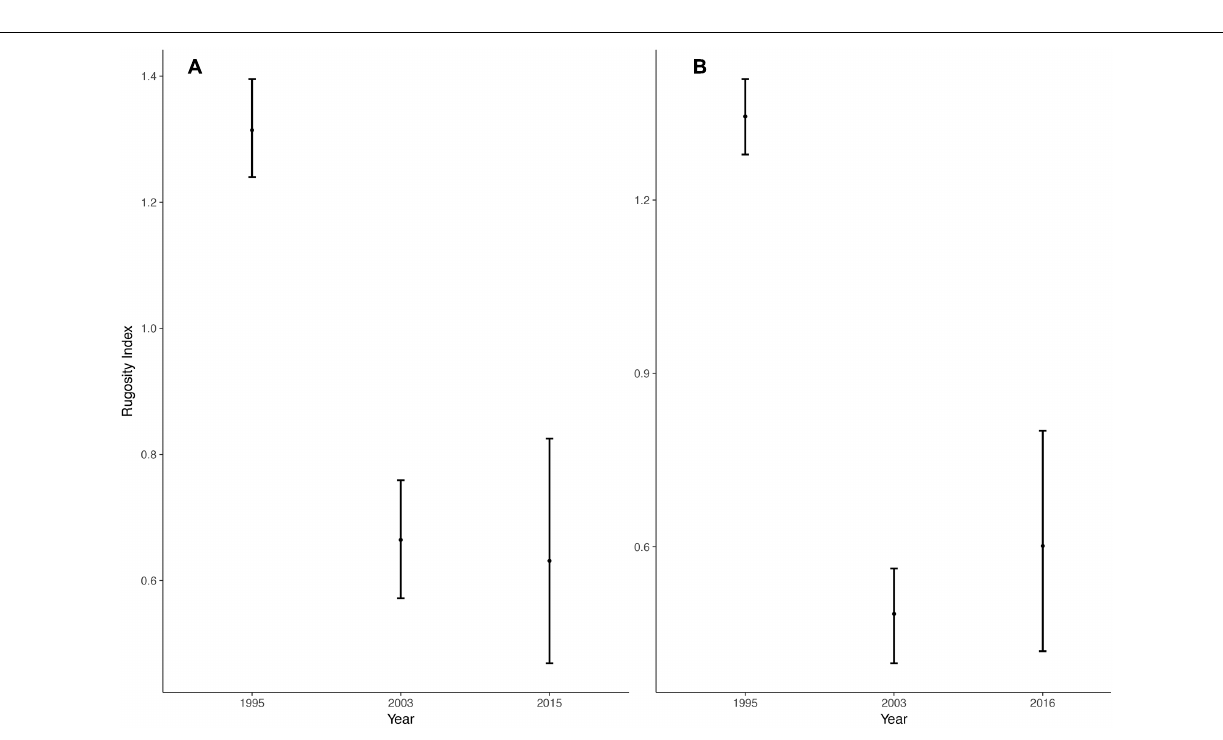
Frontiers in Marine Science |